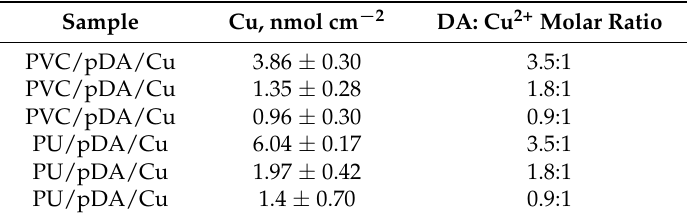
Table 1. Copper content on the surface of PVC and PU modified by dopamine from solutions with different DA:Cu 2 + molar ratios according to